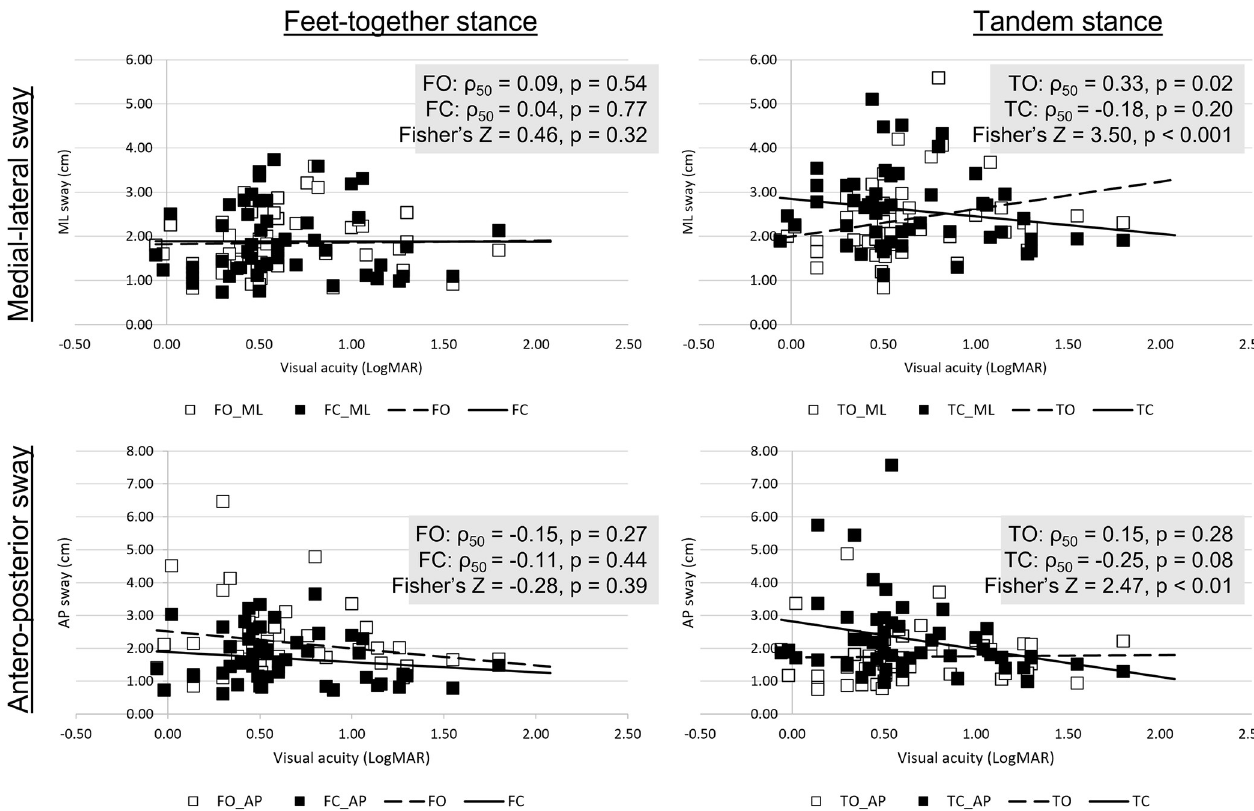
Fig 2. Relationship between distance visual acuity and static balance measures. Upper row: Medial-lateral sway (ML); Lower row: Antero-posterior sway (AP). Feet-together stance condition was denoted by F (left column, N = 52) while tandem stance condition was denoted by T (right column, N = 52). Open symbols indicate eye-open condition, while filled symbols indicate eye-closed condition. Statistical significance in Fisher’s r-to-z transformation indicates the different correlation coefficients.